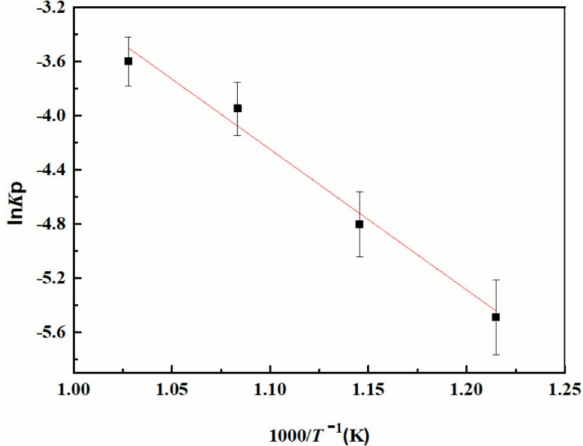
Figure 7. Graph of dependence of the parabolic oxidation rate constant from temperature for Mg